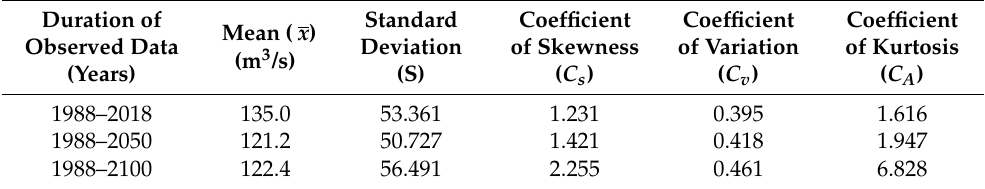
Table 5. Basic statistics for Gimhae rainfall station using RCP 8.5